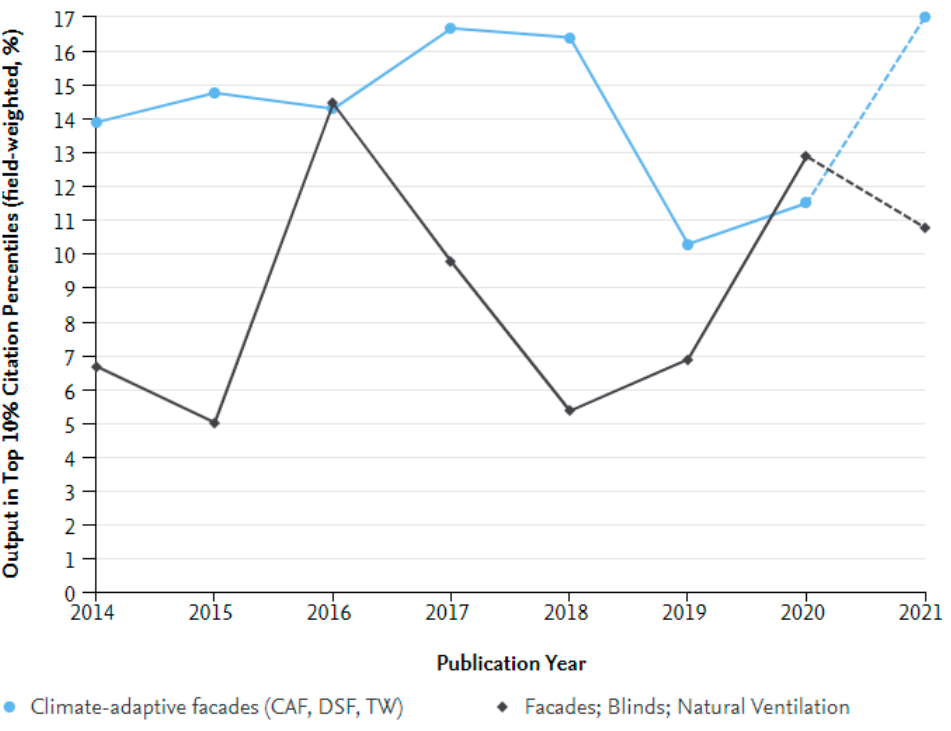
Figure 26. Benchmarking the publication year and field-weighted citation impact (accessed on 21 January 2022).